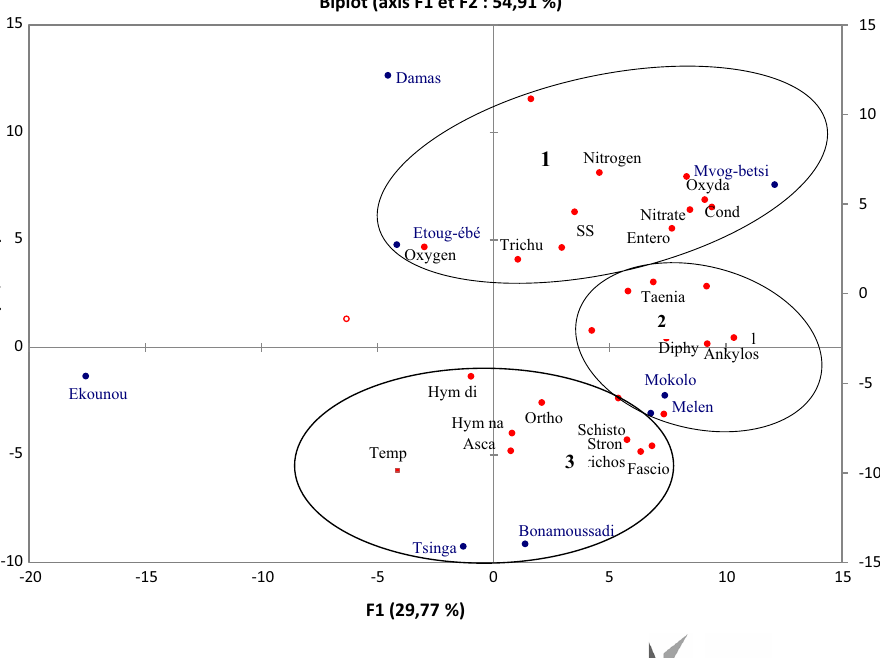
*Significant correlation to the threshold 5%, **significant correlation to the threshold Fig. 8 Principal component analysis presenting the specific- ity of each sampling station and the connections between the various measured